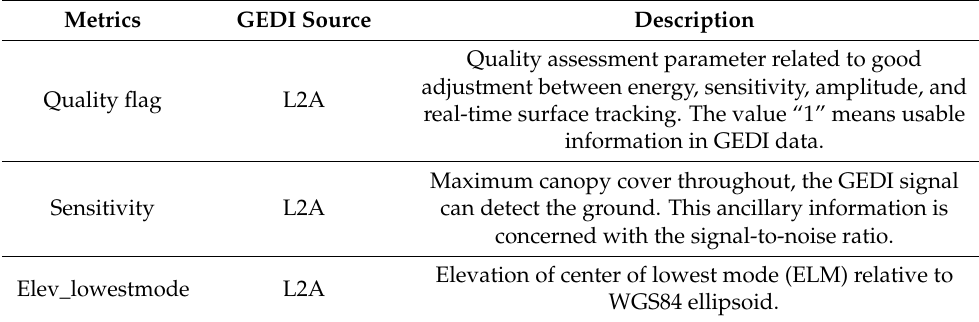
Table 1. GEDI metrics used in this study.